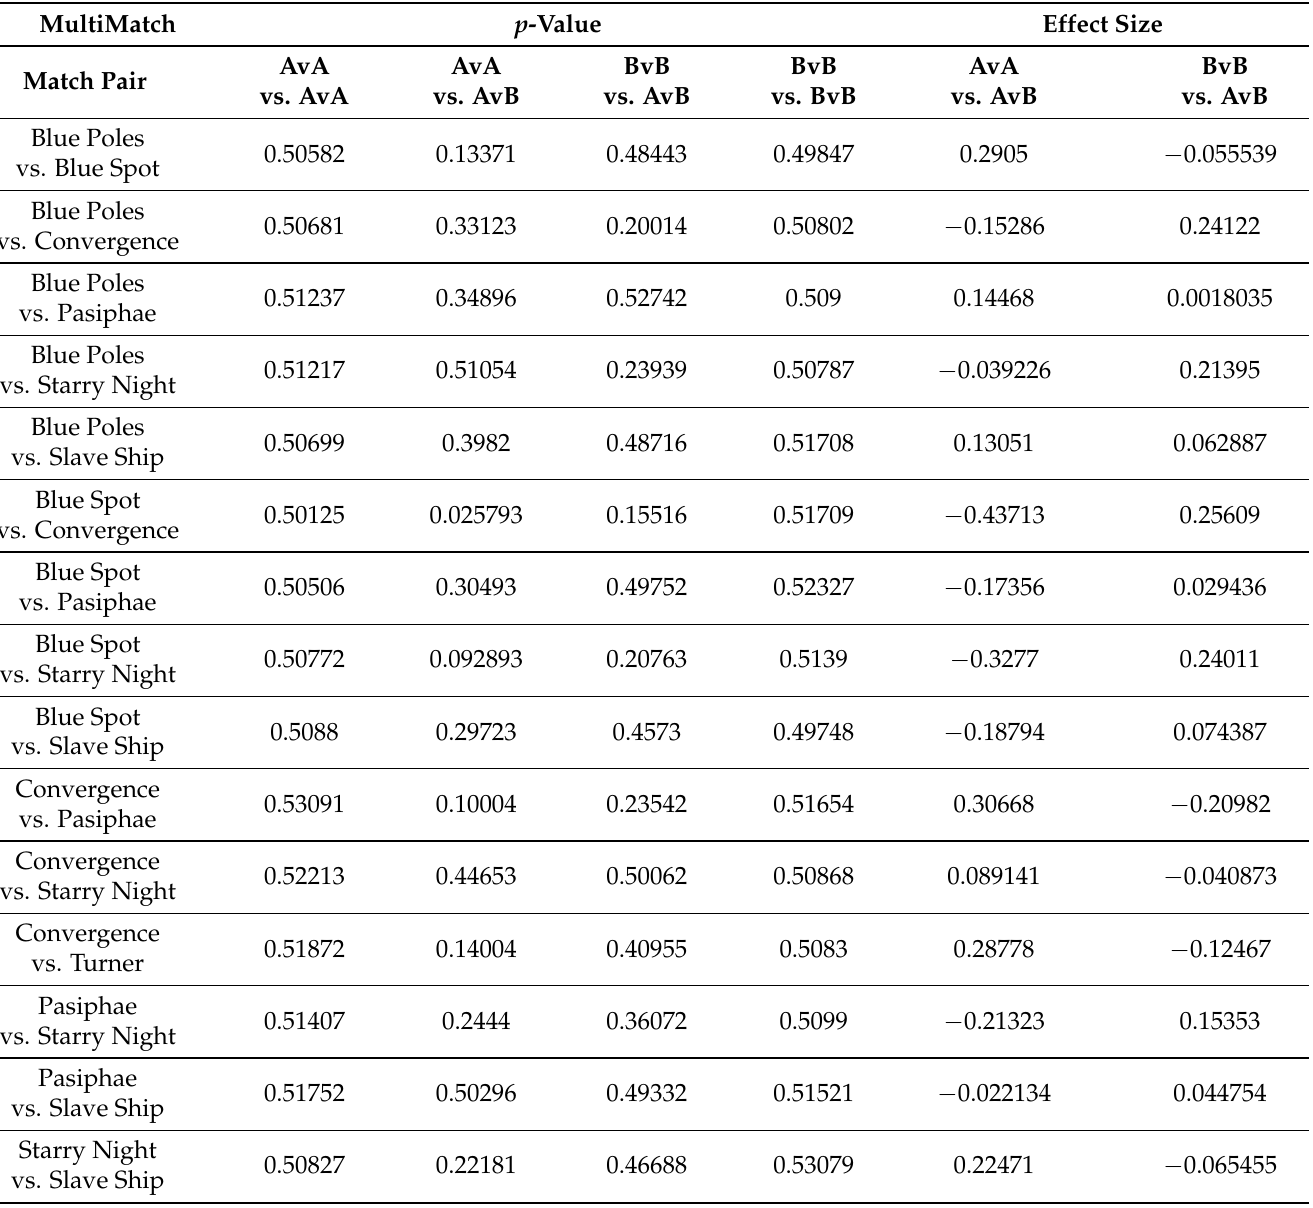
Table A7. MultiMatch duration results. Match pair (e.g., Blue Poles vs. Blue Spot), where AvA, AvB, and BvB represents a match score based on a comparison of the one member of the pair with itself, or the first member of the pair ( A ) (e.g., Blue Poles) and the second member, B (e.g., Blue Spot). The effect size for (AvA vs. AvA) and (BvB vs. BvB) in all cases was